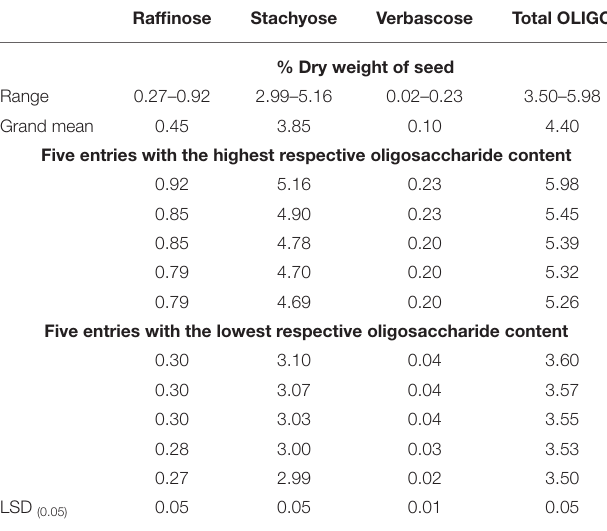
TABLE 2 | Range, grand means, and five dry bean entries with the highest and lowest respective raffinose, stachyose, verbascose, and total oligosaccharide (OLIGO) content among entries (275) grown in